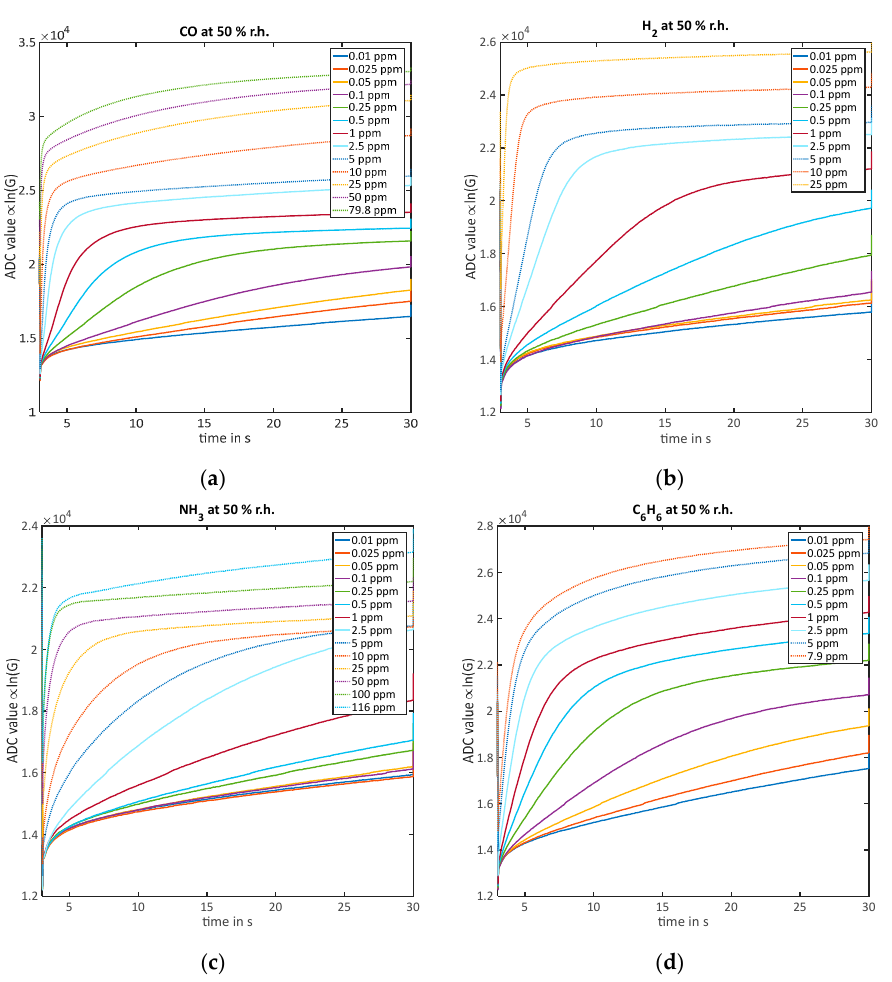
Figure 2. Measured ADC signal which is proportional to the logarithmic conductance ln ( G ) during the 150 °C temperature phase (3–30 s during the cycle) at 50% RH for all measured concentrations: ( a ) CO; ( b ) H 2 ; ( c ) NH 3 ; ( d ) C 6 H 6 .